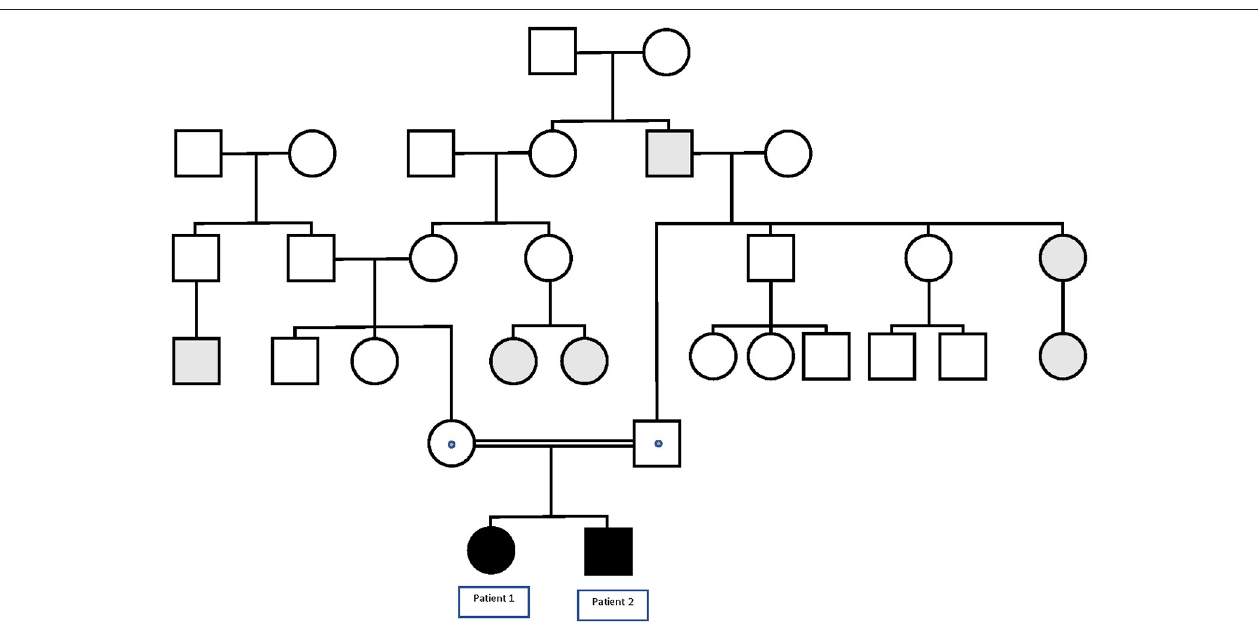
FIGURE 1 | Pedigree of the family in which the p.Lys1505Gln variant in the SCN1A gene segregates with GEFS + . Black symbols denote homozygous patients, and dotted symbols denote obligate or confirmed heterozygous healthy carriers. Gray symbols denote patients with FS or FS + .